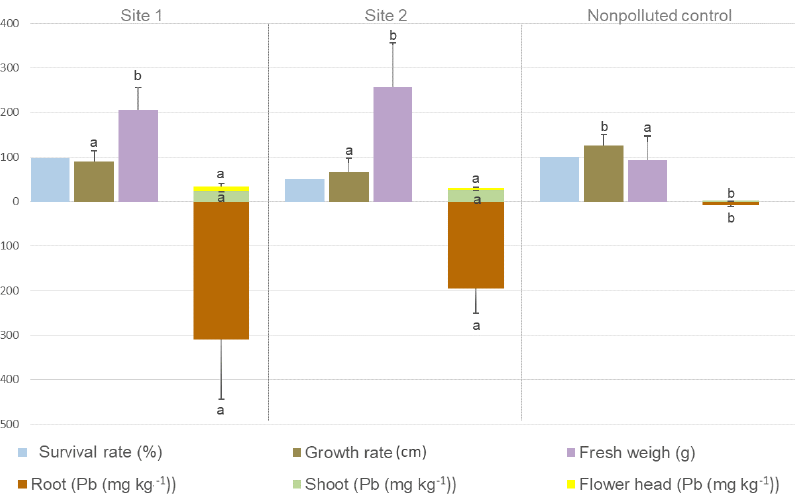
Figure 1. Survival rate (%), growth rate (cm), total fresh weight (g), and concentration of Pb (mg kg − 1 ) in roots, leaves, and flower heads of H. petiolaris plants growing on the Pb-polluted sites (1 and 2) and the nonpolluted control site. Error bars are S.E. ( n = 6). Values in the lines followed by the same letter and color are not significantly different at p ≤ 0.05 by ANOVA and Tukey test.